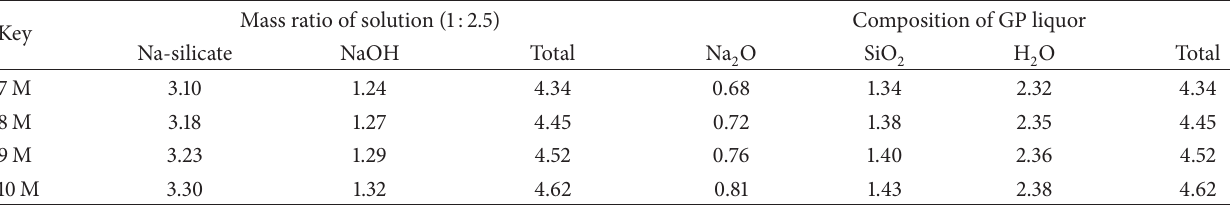
Figure 1: XRD pattern of RHA (C = cristobalite; Q = quartz). Table 1: Composition of alkali activators used for the